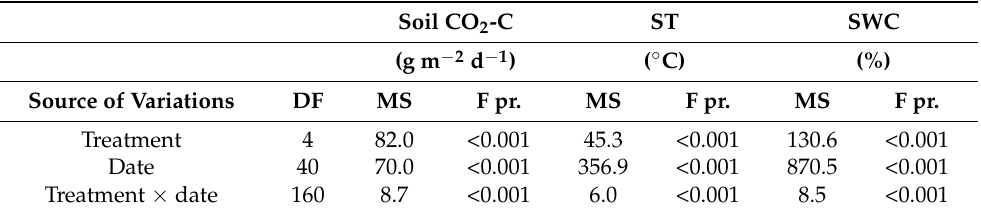
Table 1. Repeated-measures ANOVA for the effects of treatments, date of sampling and their interaction on soil CO 2 -C emissions, soil temperature (ST) and soil water content (SWC). Soil CO 2 -C ST SWC